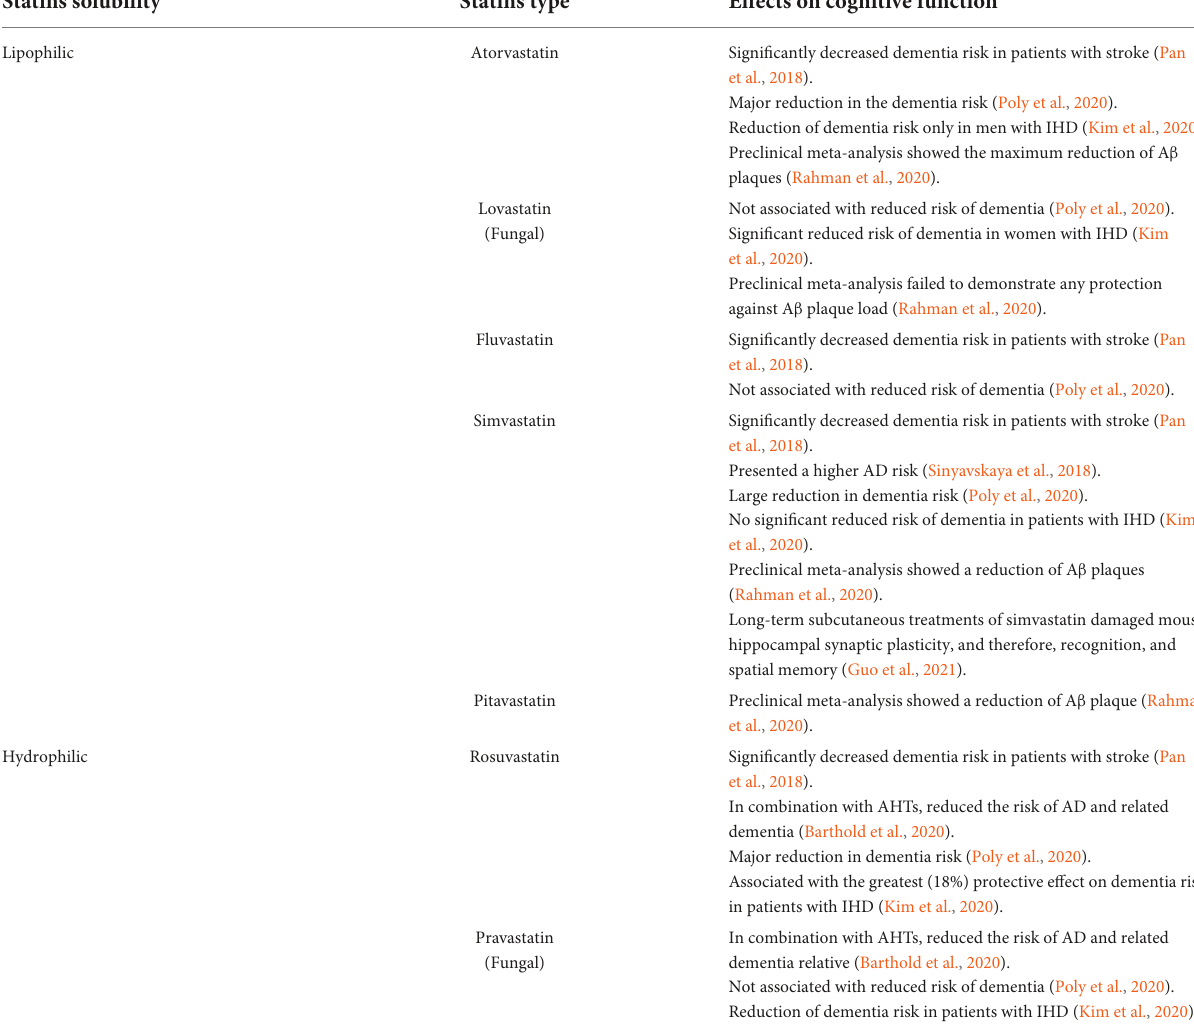
TABLE 2 The statins lipophilicity and their effects on cognitive function. Statins solubility Statins type